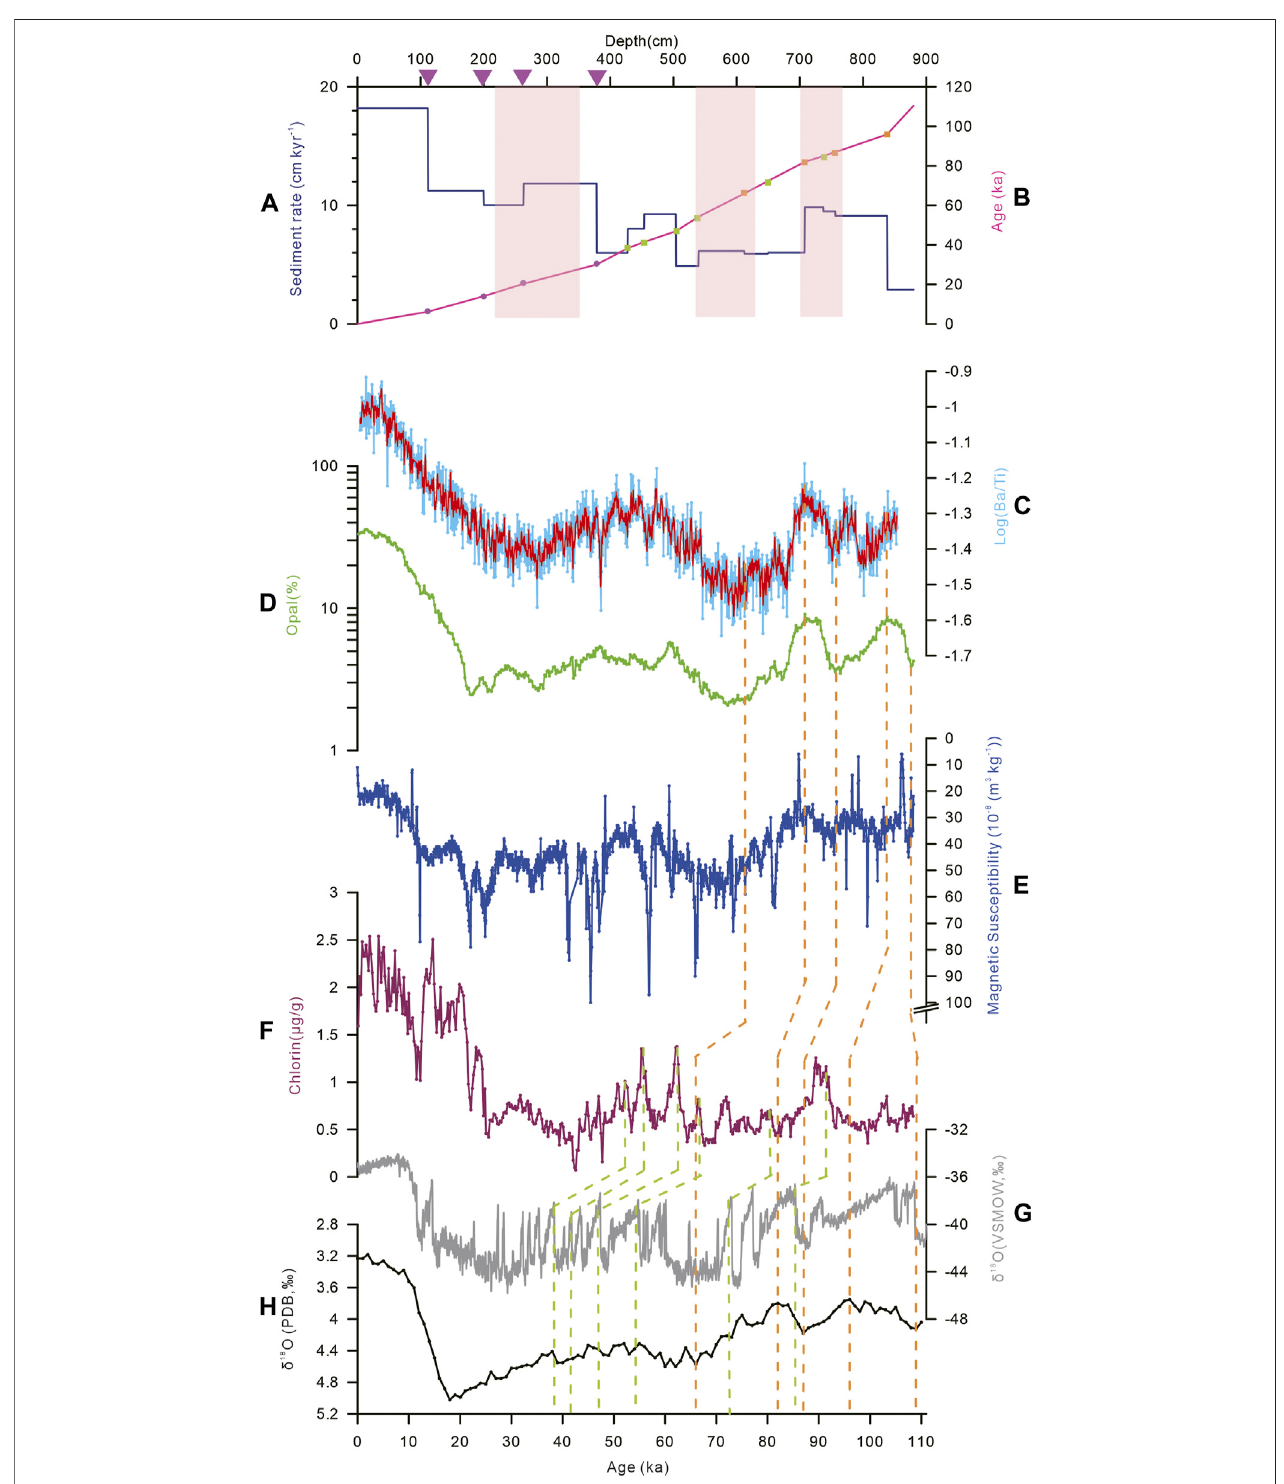
FIGURE 3 | Age model for core LV55-40-1. (A) Linear sedimentation rate, (B) Age-depth plot, (C) XRF-scanning log (Ba/Ti) ratio (blue line) with a 3-point running average (red line), (D) Opal content, (E) Magnetic susceptibility, (F) Chlorin concentration, (G) Oxygen isotopesfrom the NGRIP ice core (Andersen et al., 2004), and (H) LR04 δ 18 Ostack(Lisieckiand Raymo,2005).Purpletrianglesrepresentage modeltiepointusingAMS 14 C,orangeandgreendashedlines represent agecontrolpoints obtained using correlations between the log (Ba/Ti) ratio, opal content, magnetic susceptibility, and LR04 δ 18 O, and using correlations between chlorin concentrations and oxygen isotopes from the NGRIP ice core. Pink shadows represent glacial periods.